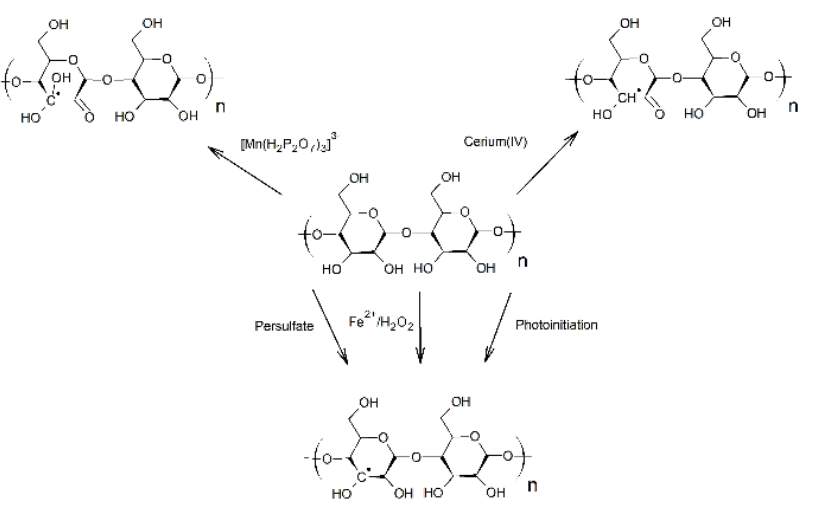
Figure 9. Mechanisms for initiation of starch graft polymerization. Table 6. Summary of grafting results for different initiation methods in starch graft polymerization.